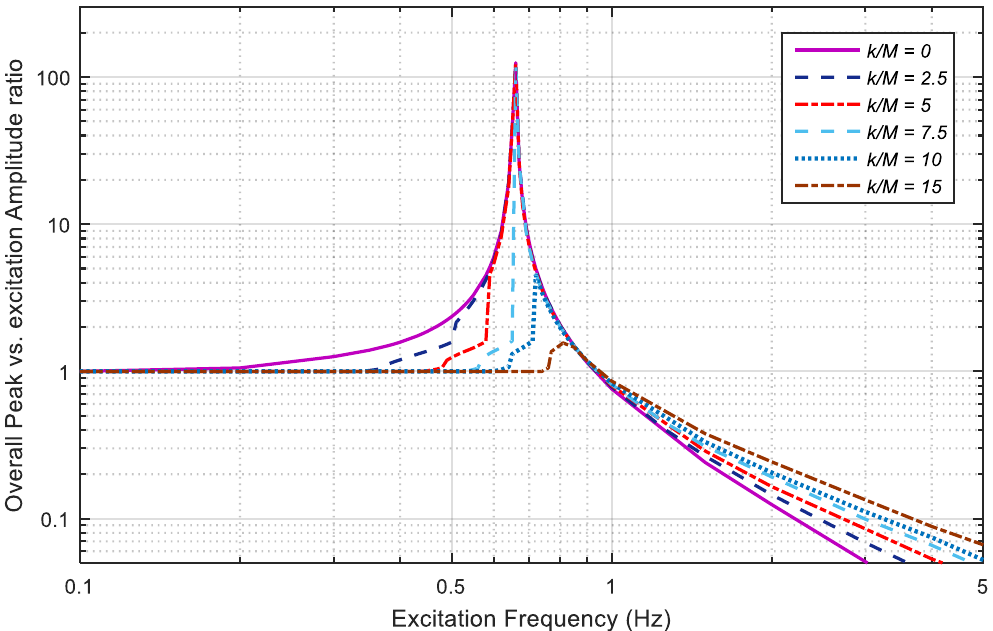
Figure 8. Overall response vs. excitation amplitude ratio according to the parameter k / M in case of U = 0.03 and ζ r = 0.3.